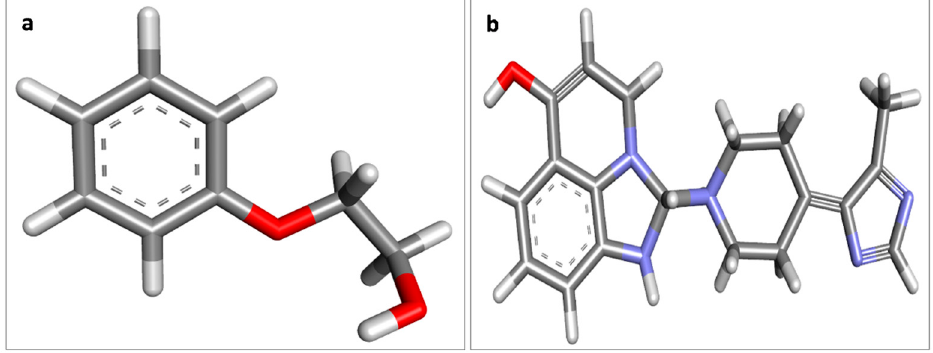
Figure 1. Structure of 2-Phenoxyethanol and imidazoquinolinone, ( a ) 2-Phenoxyethanol, ( b ) imidazoquinolinone.